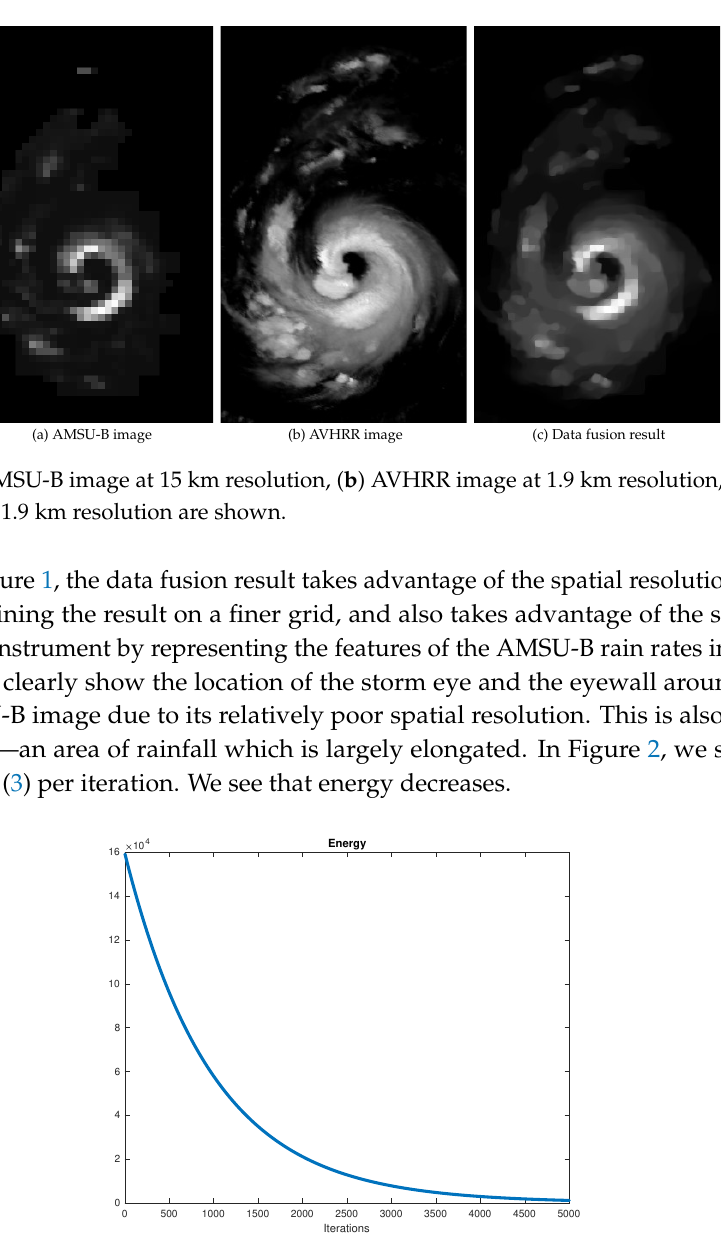
Figure 2. Energy, given by Equation (3), is plotted for the experiment shown on Figure